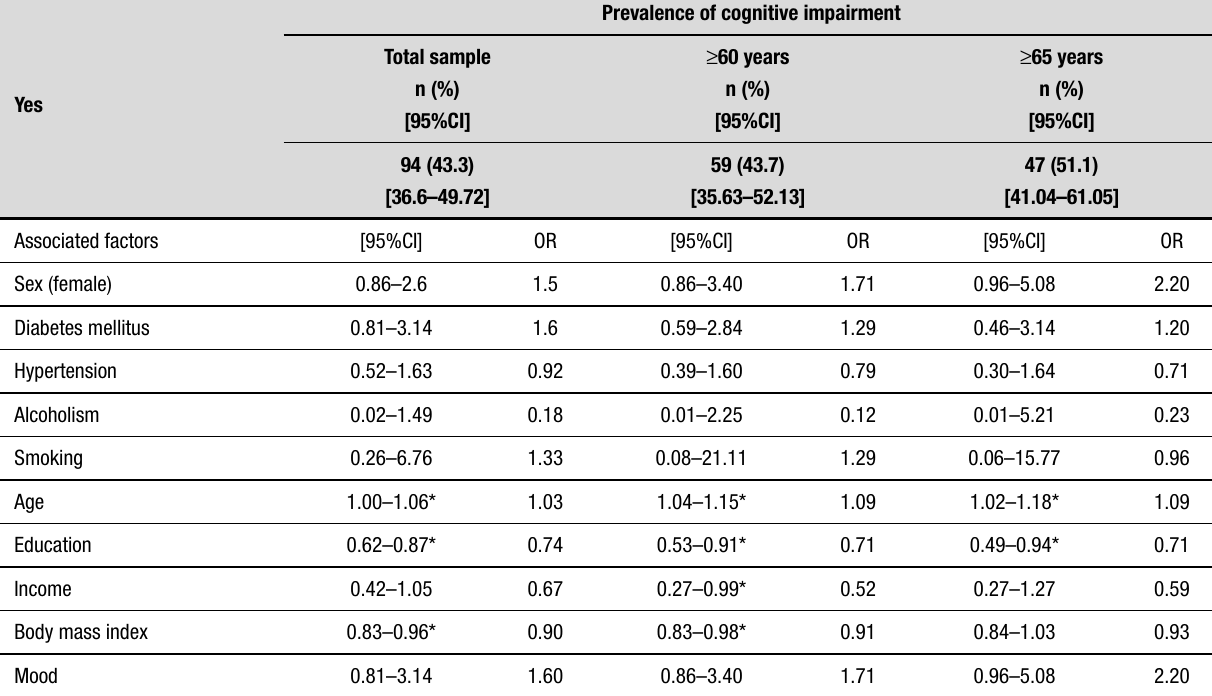
Table 2. Prevalence of cognitive impairment and associated factors.